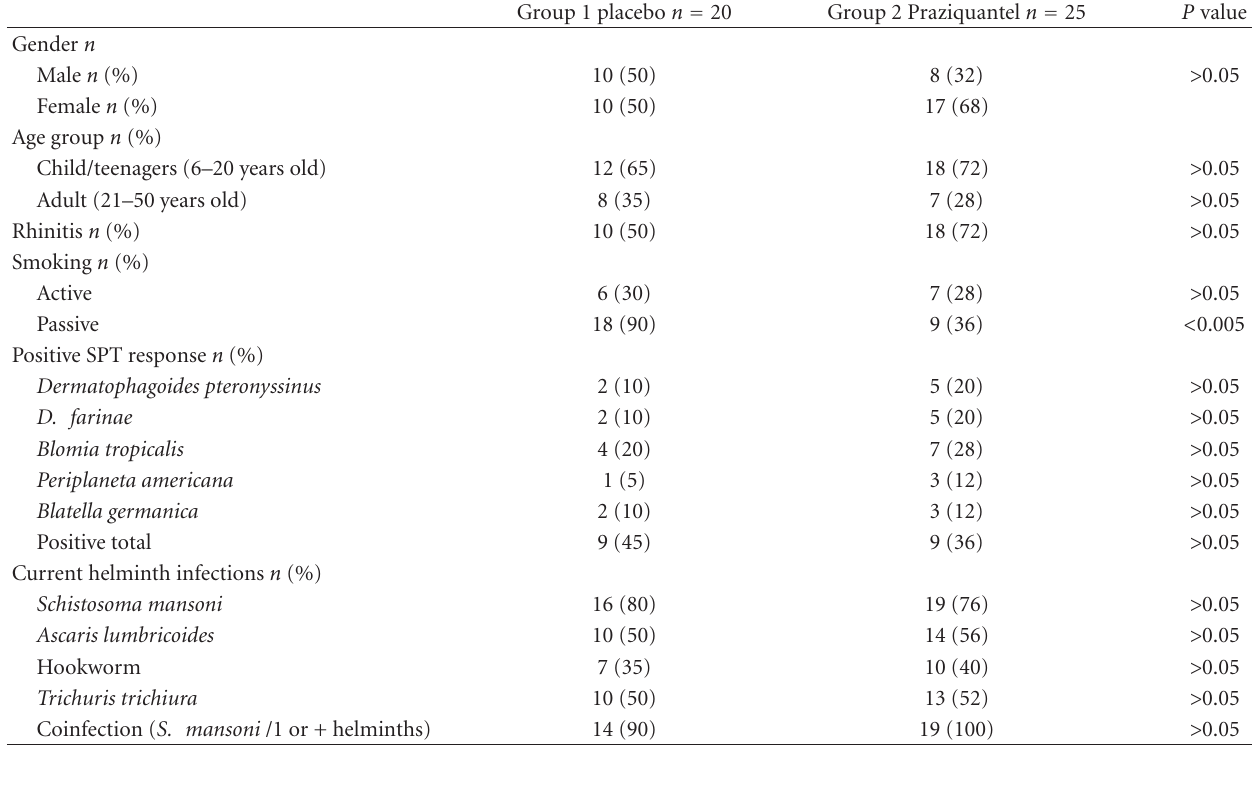
Table 1: Baseline characteristics of studied subjects.